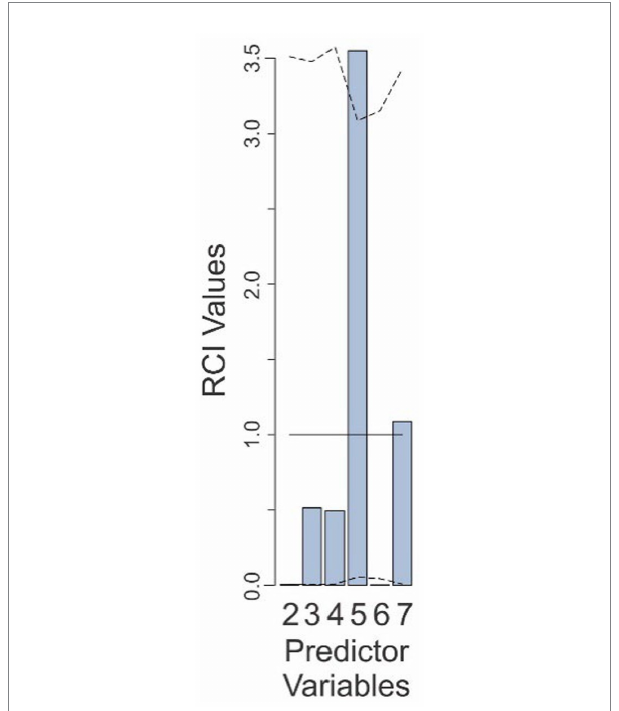
FIGURE 8 Relative contributions of various predictors to the fit of the Final Model in Experiment 4. The predictor variables are those that are retained in the Final Model and are numbered as in Table 4. The solid line denotes the expected contributions of the various predictors. The dashed lines denote the upper and lower 95% confidence intervals (uncorrected), empirically determined from the data. See text for